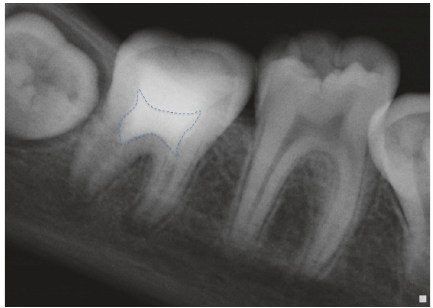
Figure 1: Initial radiography: tooth 47 with radiolucent images at the mesial and distal roots.